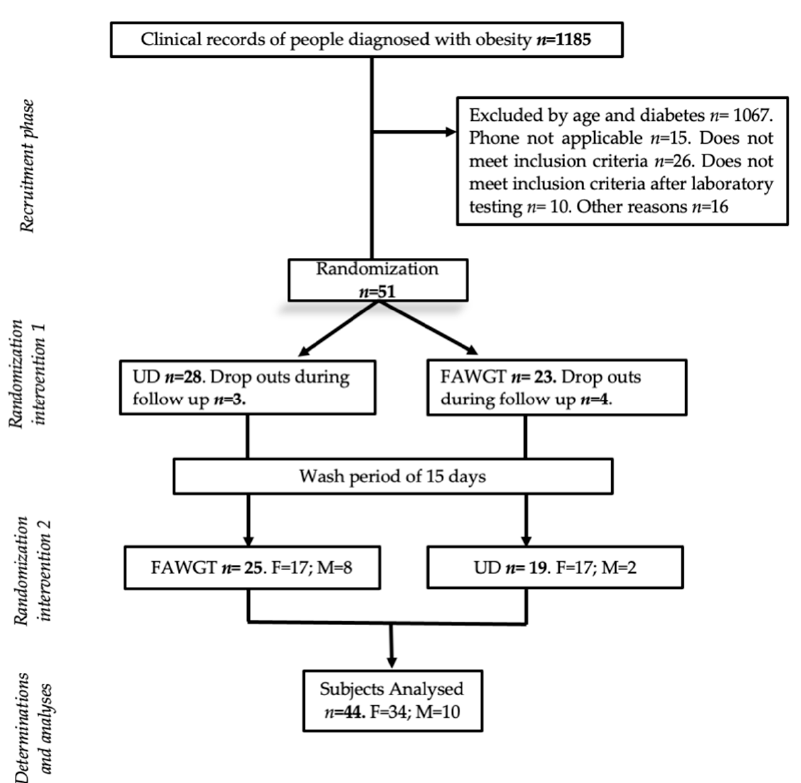
Figure 1. Flow chart of participants and study design. From 1185 medical records of patients diagnosed with obesity, 51 subjects were recruited, of whom 28 were randomized to follow the usual diet and 23 to the FAWGT diet. After 8 weeks of intervention, 7 subjects dropped out of the study and the remaining subjects changed their dietary pattern. Finally, 44 subjects completed the study. F, female; M, males; UD, usual diet; FAWGT, diet composed of fruit, avocado, whole grains, and trout.